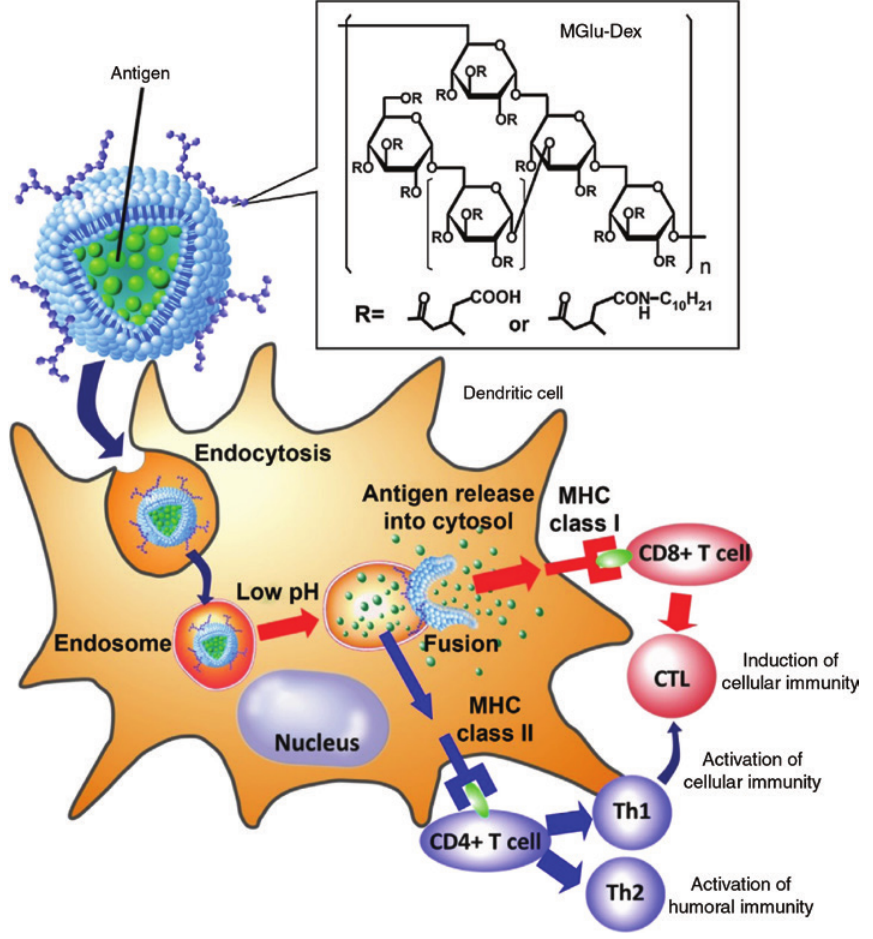
Figure 7: Design of MGlu-Dex-modified liposomes as a vaccine for induction of antigen-specific immunity. MGlu-Dex-modified liposomes are taken up by dendritic cells (DC) via endocytosis and trapped in endosome. The weakly acidic DC cytosol induce the formation antigen- specific cytotoxic T lymphocytes (CTL) via presentation by MHC class I, resulting in induction of cellular immunity (Th1 response). Antigen molecules in the endosomes undergo presentation by MHC class II and induce antigen-specific Th2 cells that lead to induction of humoral immunity. Reprinted with permission from Ref. [117], copyright 2014,